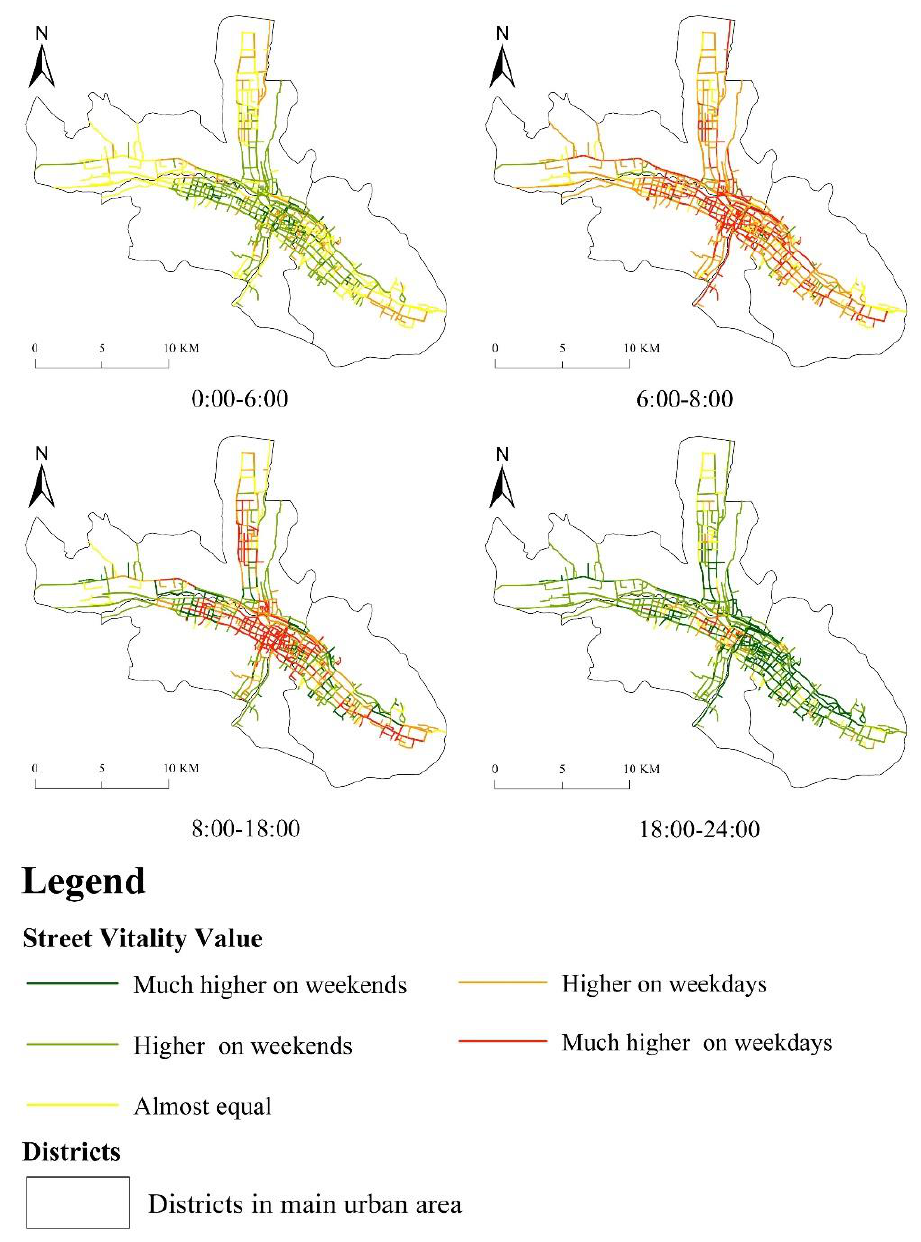
Figure 5. Comparison of street vitality values on weekdays and weekends.